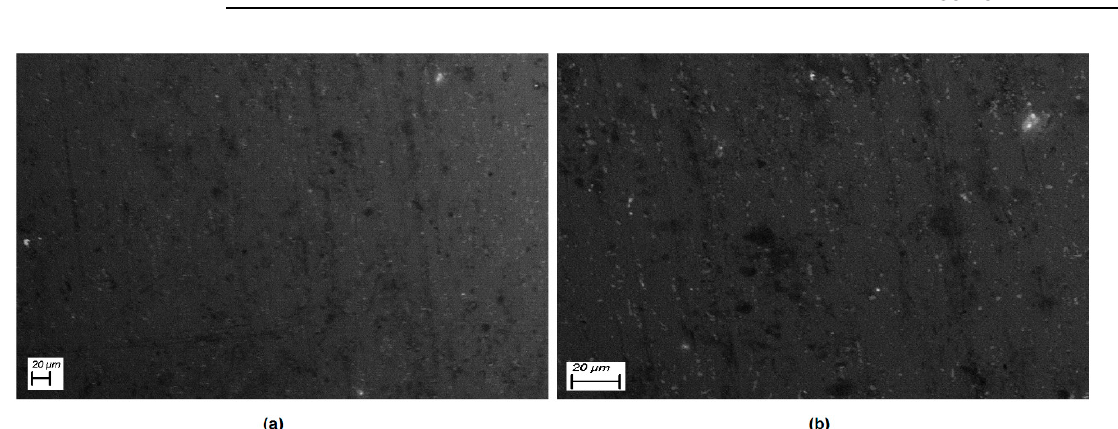
Figure 5. SEM for ZnQ 2 -TCNQ film at ( a ) 500 × and ( b ) 1000